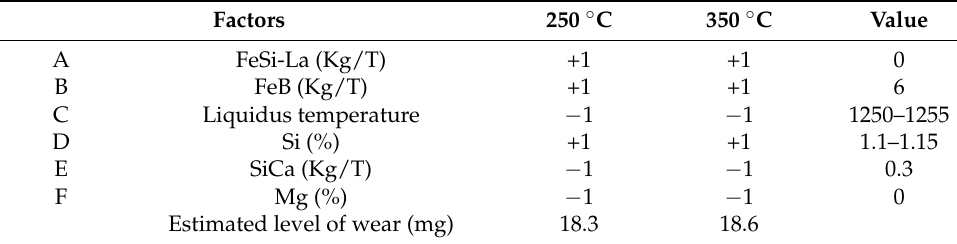
Table 11. Optimum combination of levels to minimise wear in zone